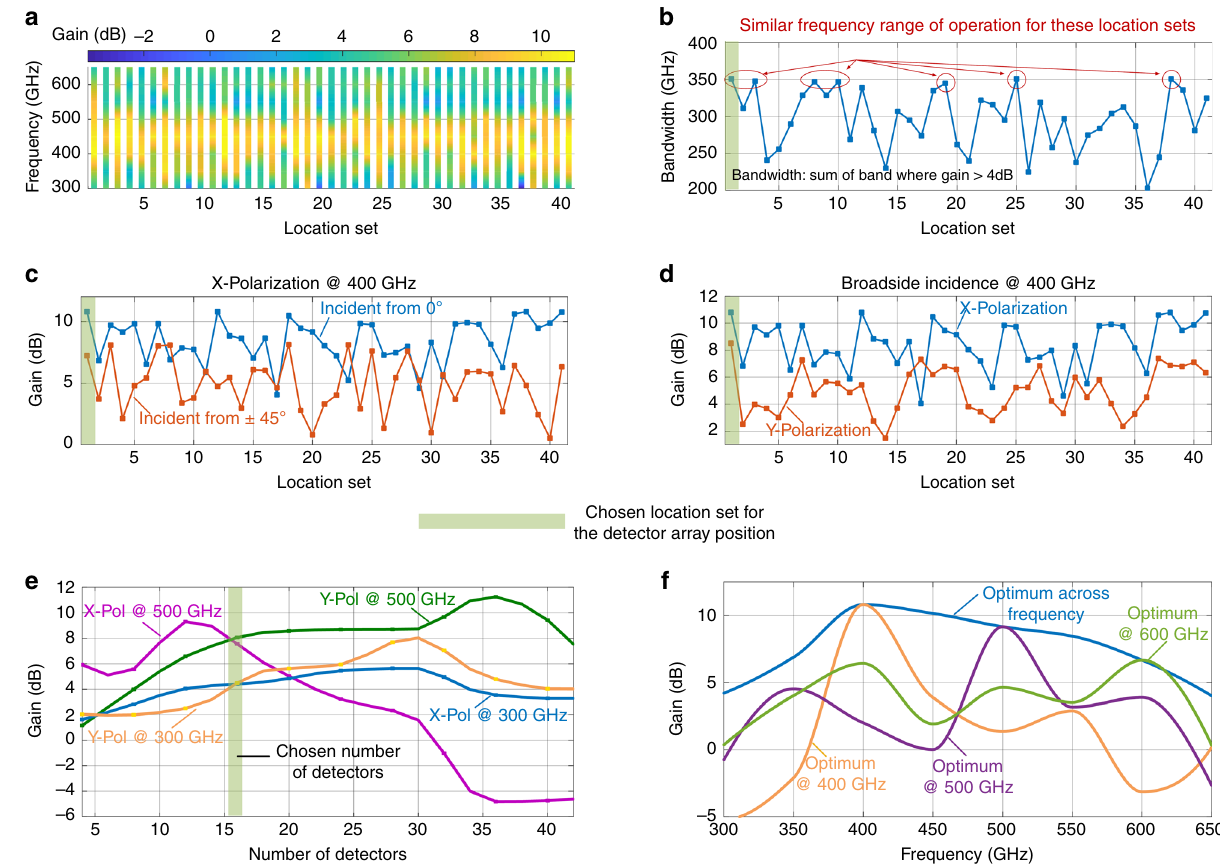
Fig. 5 THz response recon fi gurability and its trade-off with the location and number of recon fi guration sites. a Simulated optimized gain with varying locations of the 16 detectors and its effect on peak responsivity and frequency range of operation. b Simulated variations of bandwidth with location sets of the 16 detectors. The fi gure demonstrates that more than one solution set can exist to achieve a similar frequency range of operation. c , d Simulated optimized gain with varying locations of the 16 detectors for different angles of incidence and polarization at 0.4 THz. e Simulated gain variations with the number of detectors for various incidence fi elds. f For the fi nal design, the fi gure shows the instantaneous frequency response as the sensor is optimized for various peak frequencies. The optimal recon fi gurable sensor response of the chip follows the peak of these individual frequency response